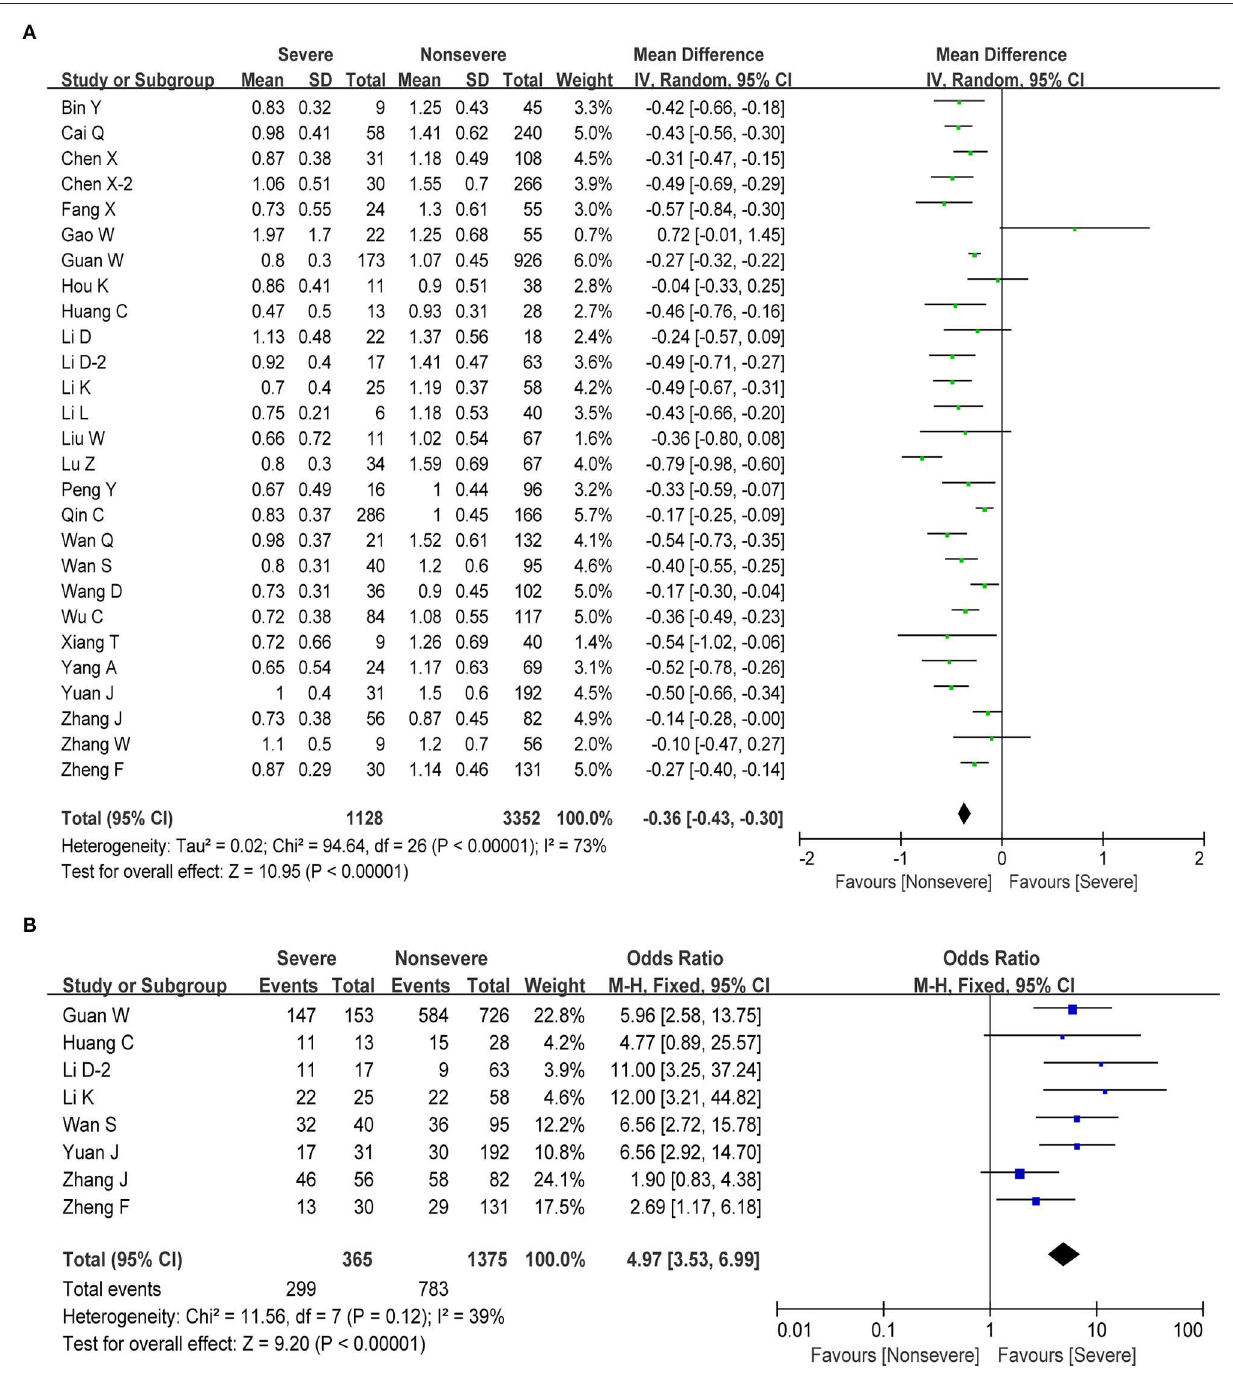
FIGURE 3 | Correlation between lymphocyte and disease severity of COVID-19. (A) Forest plot of mean difference in lymphocyte count. (B) Forest plot of OR for the association of lymphopenia with disease